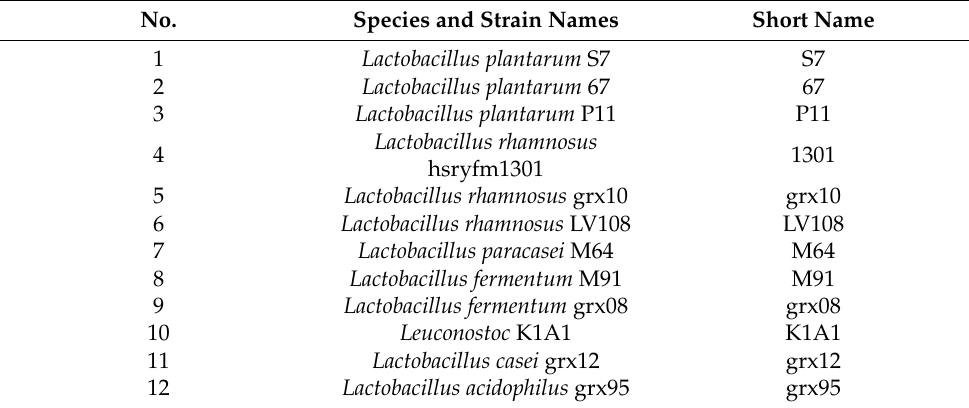
Table 2. Species and strain names used in this